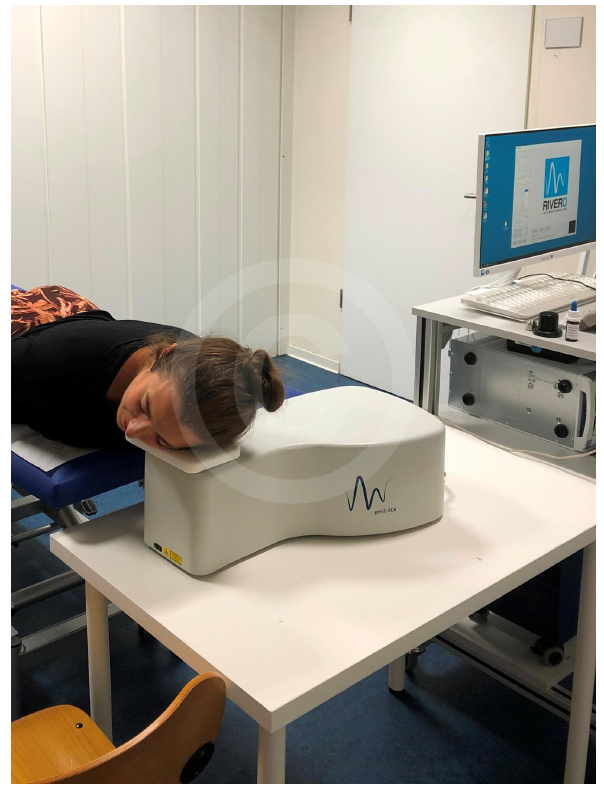
Figure 2. Measurement by Raman-Spectrometry (Copyright proDERM).